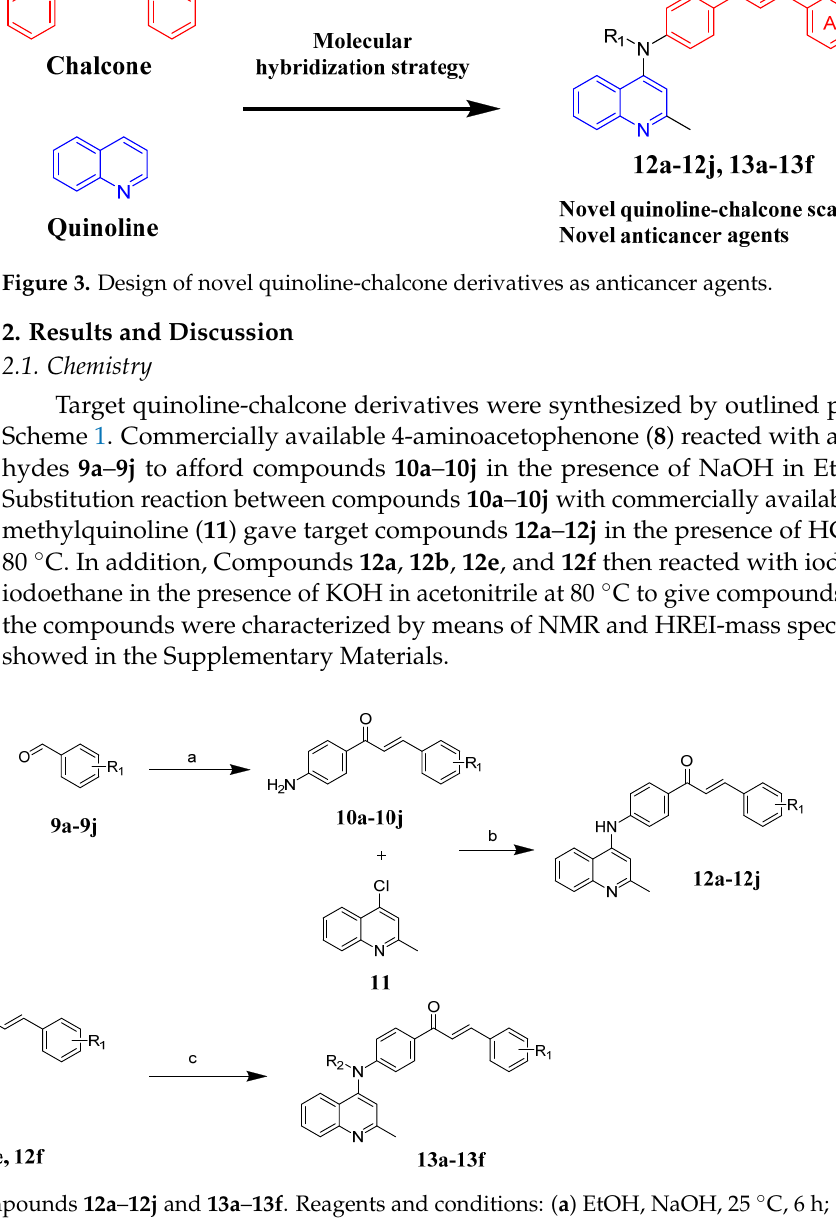
Figure 2. Structures of quinoline derivatives as anticancer agents previously reported.